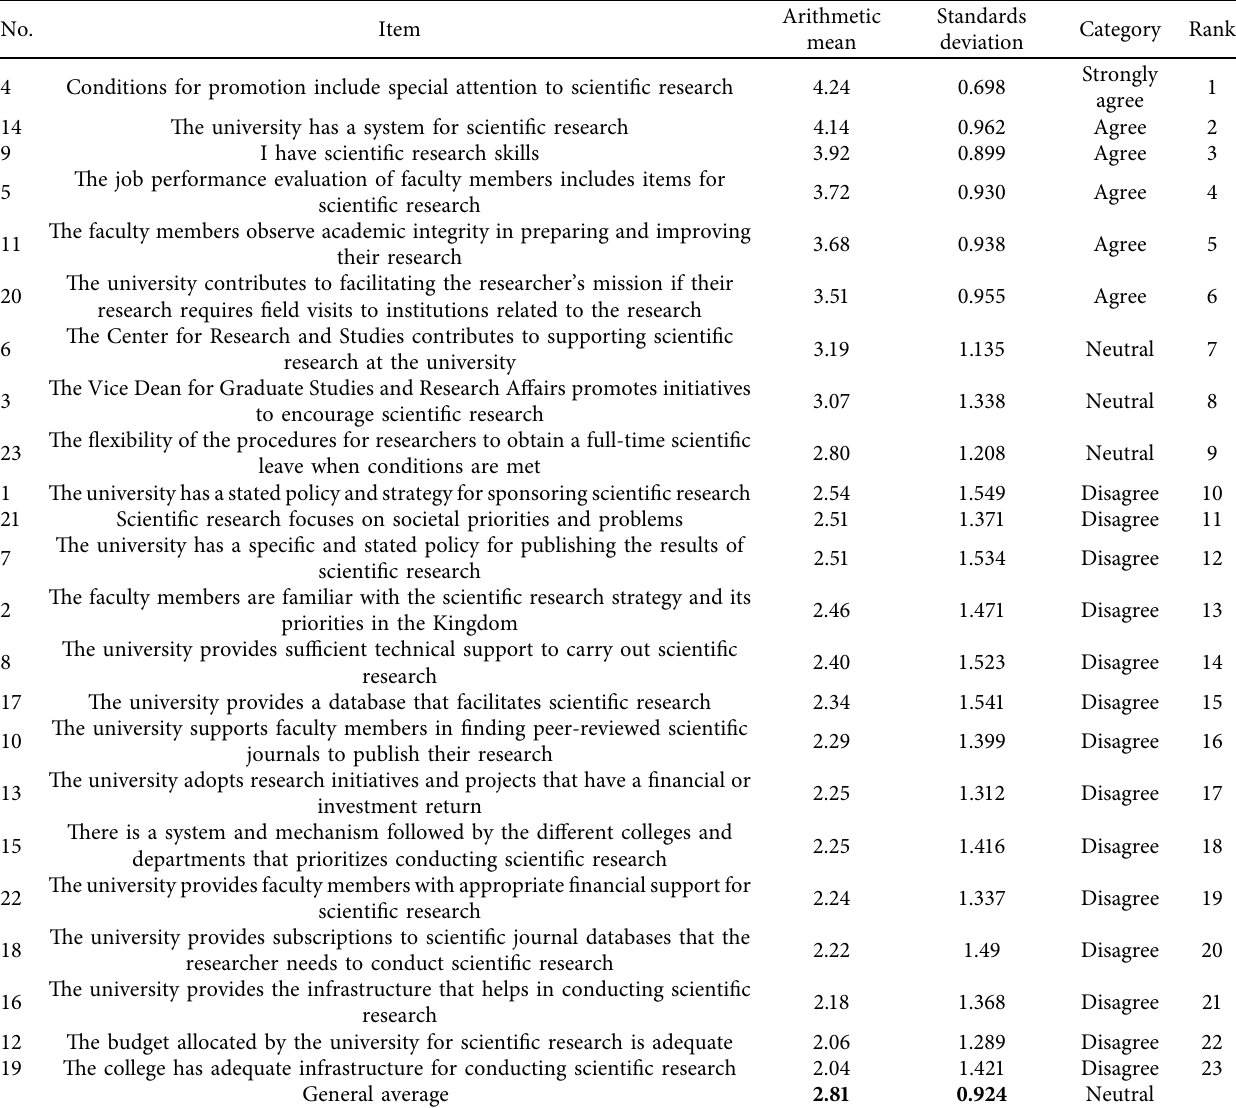
Table 6: Study participants’ responses to the theme “reality of the scientific research in the area of educational sciences during corona pandemic in Saudi universities in descending order as per the approval averages.”